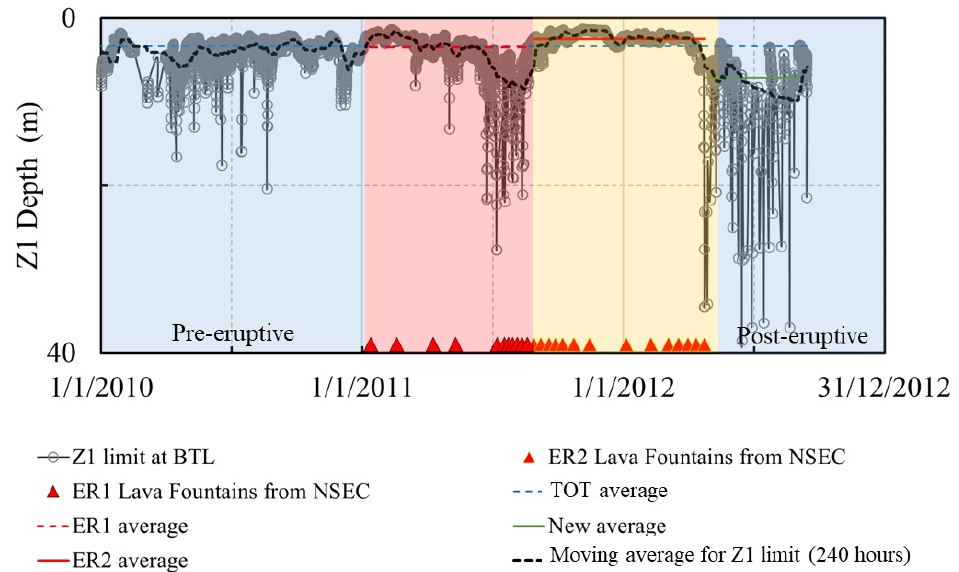
Figure 4. Time variation of the Z1 depths showing the pulses of the convective front below the BTL station. The different colors in the background indicate the different volcanic phases. Table 1. List of the peaks of SHS Flux labeled in Figure 5, with timing and intensity. The background colors indicate the different volcanic